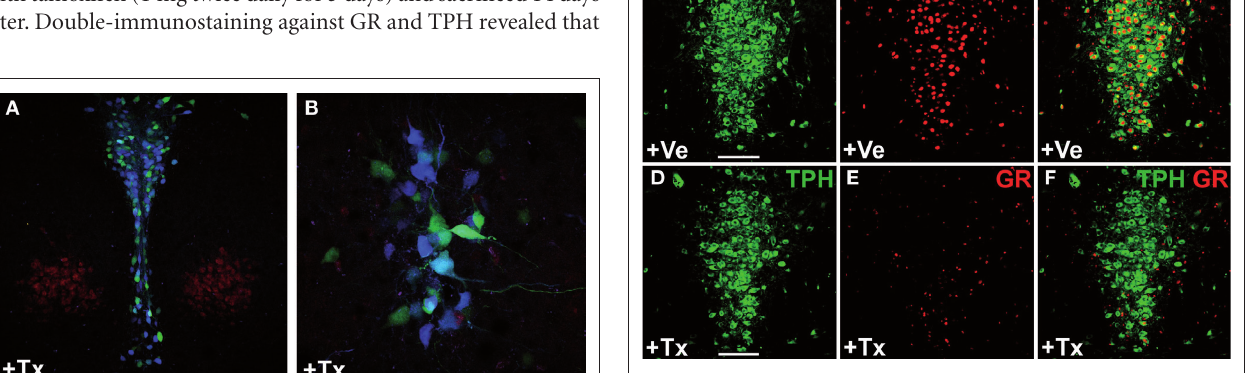
FIGURE 5 | Inducible recombination in adult Brainbow1.0L TPH2-CreERT2 mice leads to combinatorial expression of CFP and YFP in serotonergic neurons. Tamoxifen ( + Tx) (1 mg twice daily) was injected for fi ve consecutive days starting at P90. (A,B) One week later, mice were sacrifi ced and red, cyan and yellow fl uorescence emission was analyzed by confocal microscopy at the level of dorsal raphe nuclei. Stochastic recombination of loxP-fl anked fl uorescent genes leads to CFP and YFP expression. Depending on the ratio of CFP to YFP expression, each 5-HT neuron shows a distinct color ranging from dark blue (only CFP expression) to yellow (only YFP expression). (B) Fluorescence labeled neuronal projections are easily detectable. Scale bars: (A) 100 µm, (B) 20 µm.